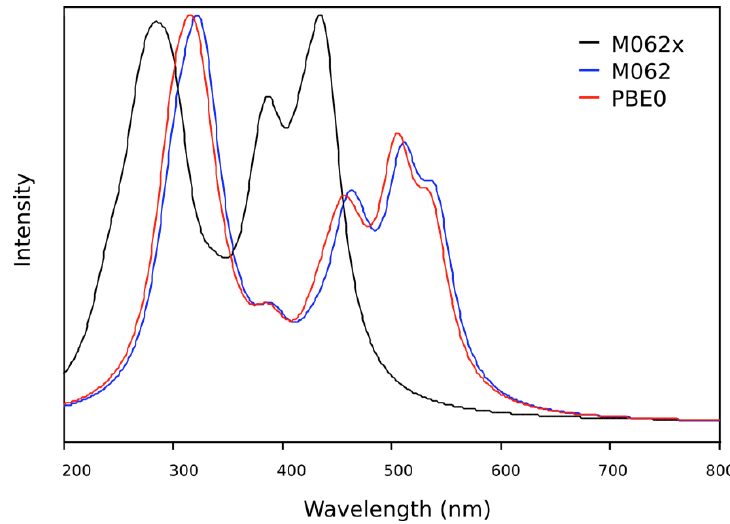
Figure 10. TD-DFT UV/visible spectrum of OIC2MS , calculated for the gaseous state using the M062x functional (black line), M06 functional (blue line) and PBE0 functional (red line).